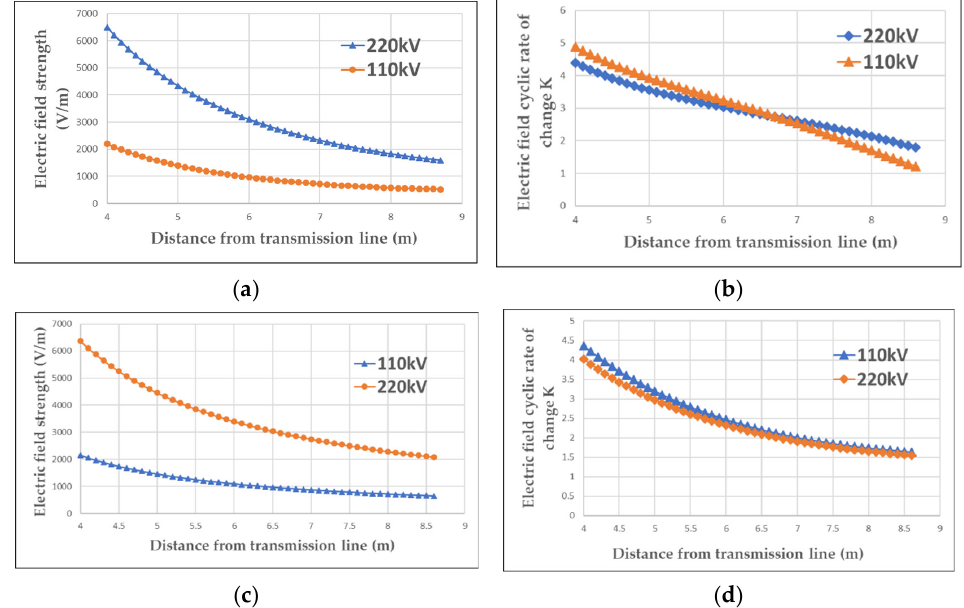
Figure 8. 110 kV and 220 kV positive triangle arrangement and inverted triangle arrangement electric field strength and K value curve. ( a ) Electric field strength of 110 kV and 220 kV inverted triangle arrangement diagram; ( b ) K value curve of 110 kV and 220 kV inverted triangle array electric field ring specific change rate; ( c ) electric field strength of 110 kV and 220 kV positive triangle arrangement diagram; ( d ) K value curve of 110 kV and 220 kV positive triangle arrangement electric field ring specific change rate.